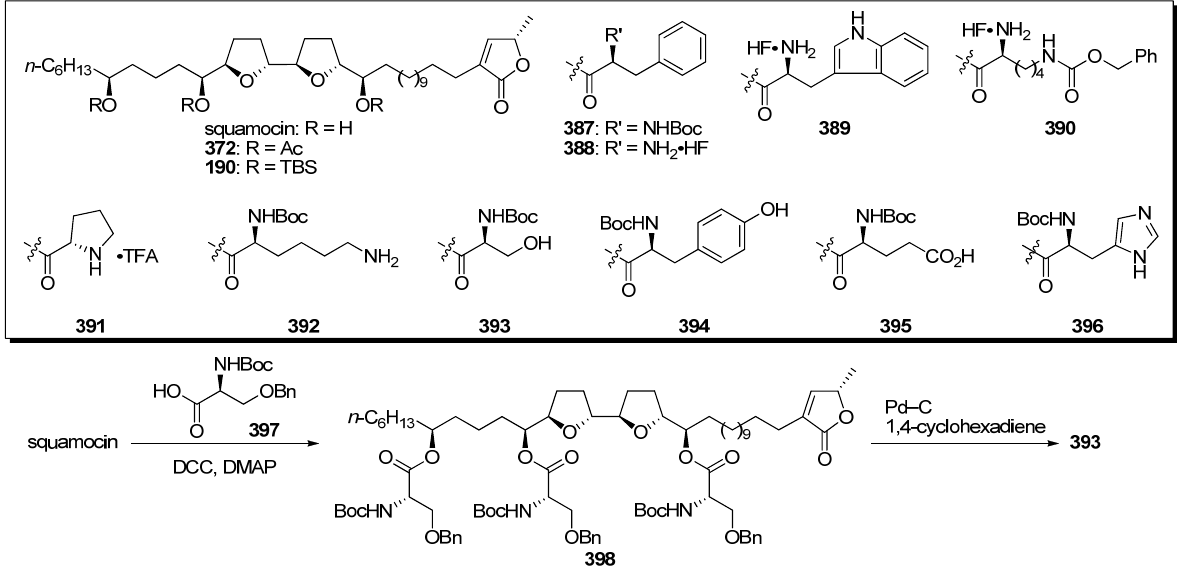
Table 29. Inhibitory potency against complex I and cytotoxicity against cancer cell lines. Compounds